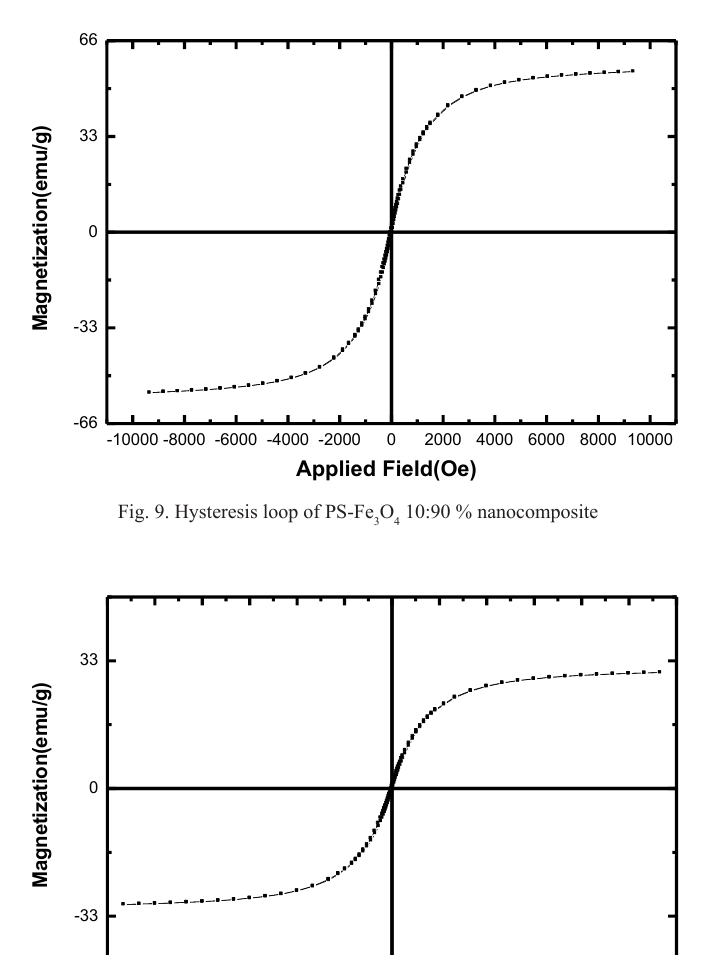
O 50:50 % nanocomposite 3 4